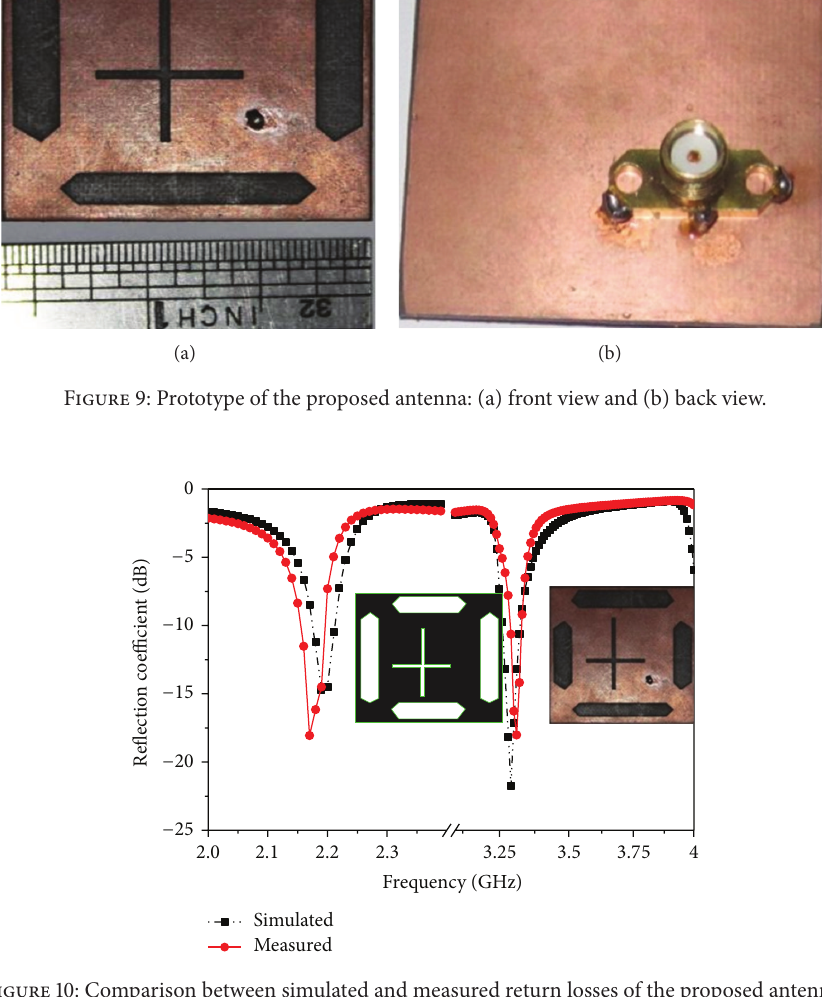
Figure 11. Pyramidal shape electrically thick foam absorber has been used on the wall, ceiling, and floor with less than − 60 dB reflectivity at normal incidence. A turn table of 1.2